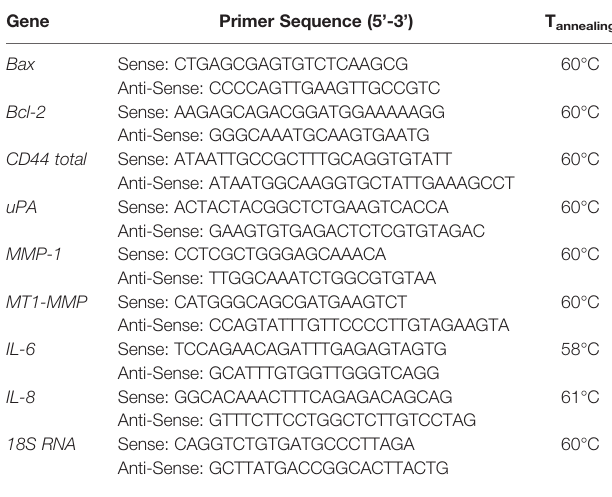
TABLE 1 | Primer sequences used for quantitative